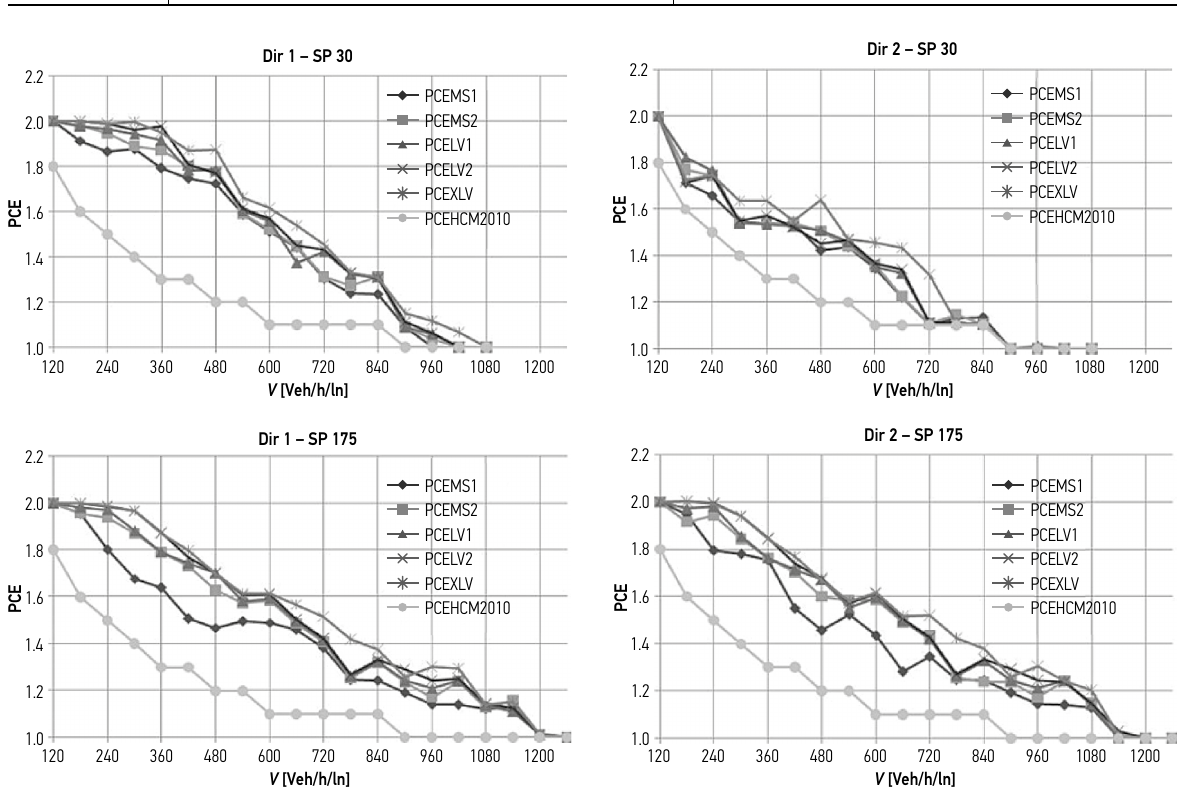
Fig. 4. PCE for different ‘traffic volume’ classes